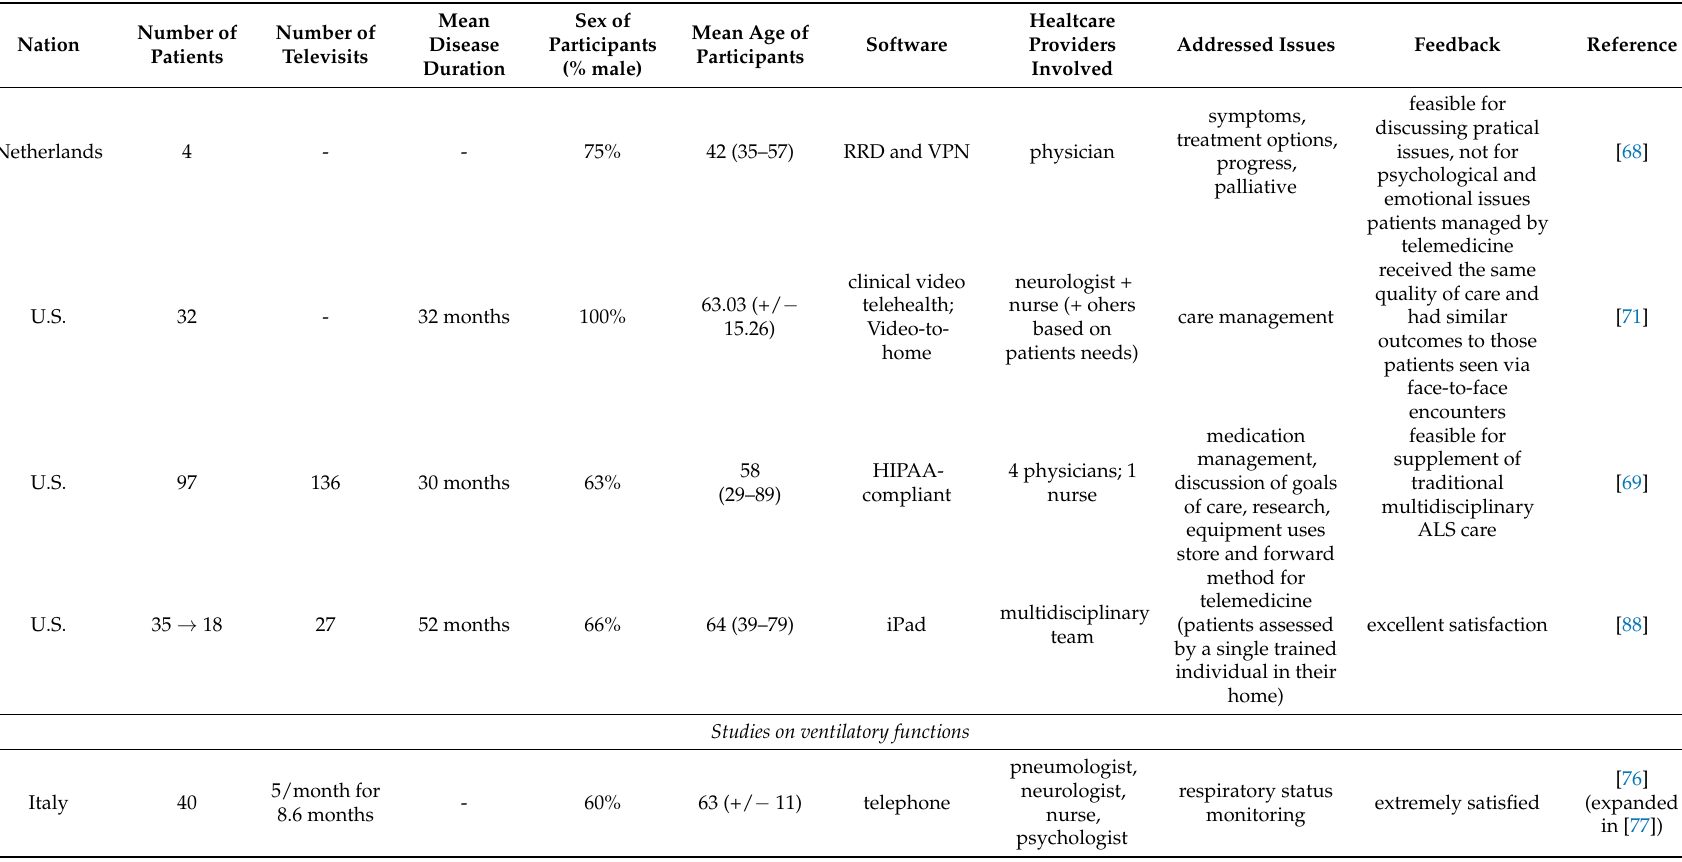
Table 4. Telemedicine studies in Amyotrophic Lateral Sclerosis. Continuous variables are expressed as mean (SD or confidence interval), unless otherwise specified. RRD: Roessingh Research and Development; VPN: virtual private network; ER: emergency room; NIV: non-invasive